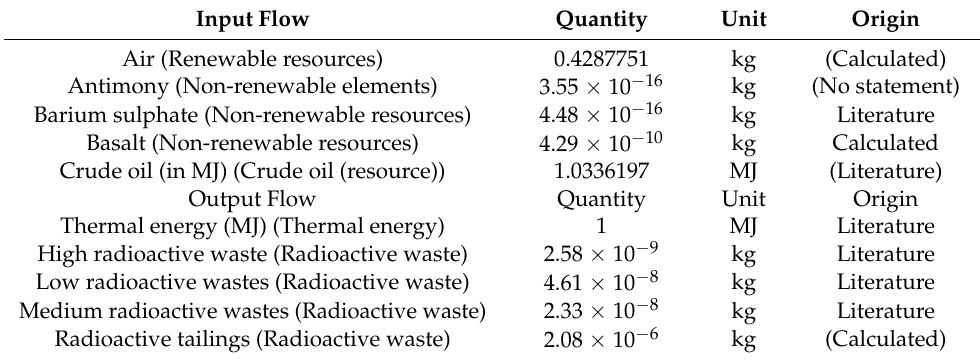
Table 2. The sample LCI for the LPG consumed in the brazing process.